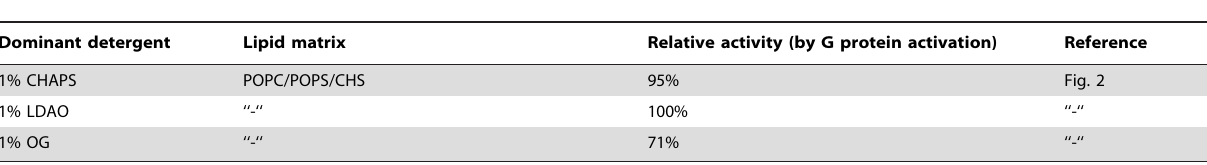
Table 2. Reconstitution of purified CB 2 into